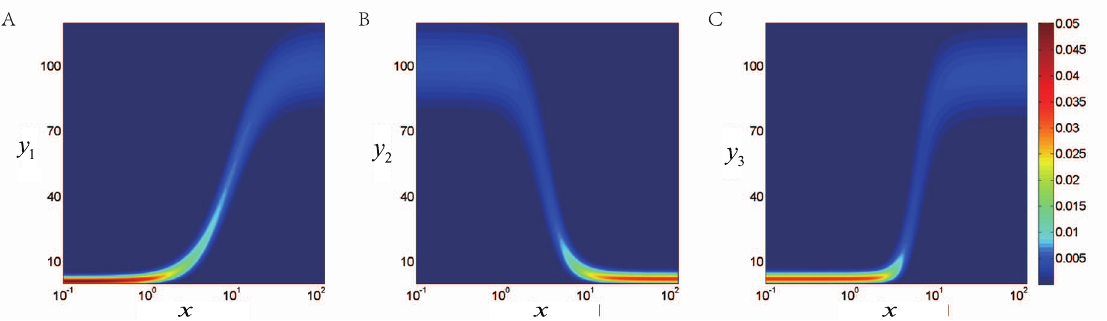
Figure 7. The dose response curves and probability distribution of the output protein in the 3-layer cascades (denoted by y 1 , y 2 , y 3 ) as a function of inducing signal x , 1-layer in (A), 2-layer (B) and 3-layer (C). The probability distribution can be directly obtained from Eq. (15) after normalization. The Hill coefficient for each cascade is fitted as 2.00, 3.15 and 4.08 respectively.